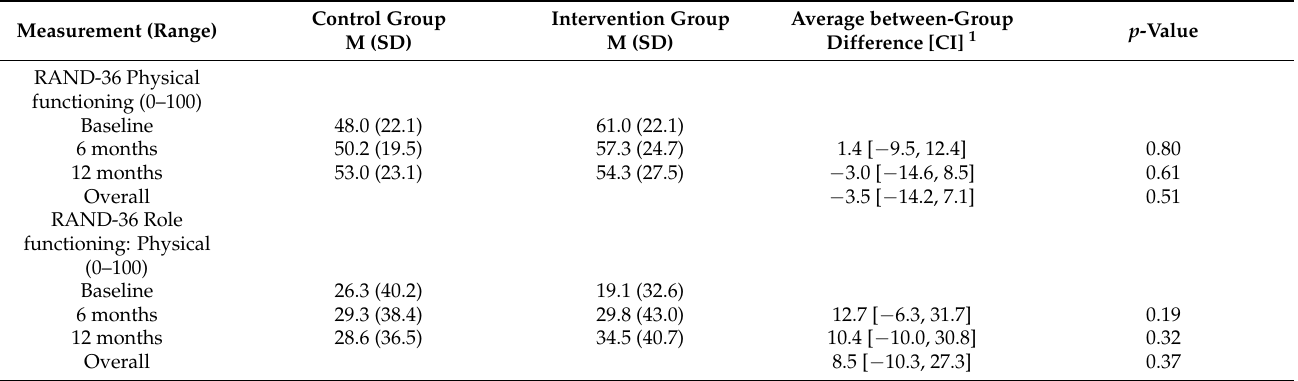
Table 3. Effects over time: Secondary